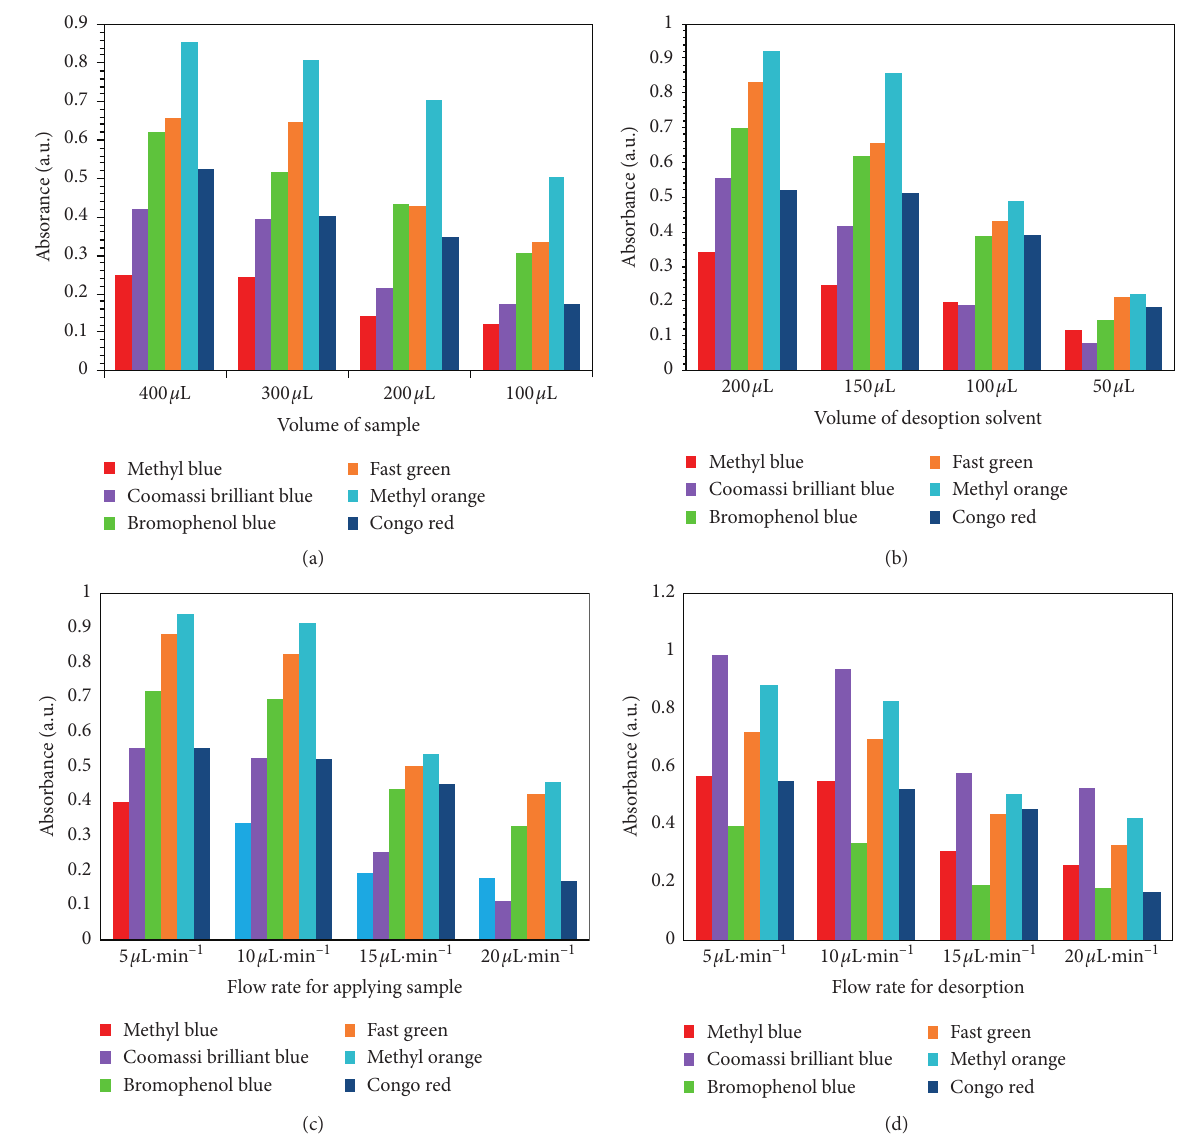
Figure 11: Effect of volume of dye sample solution on the extraction efficiency of dyes (a), volume of acetone (b), flow rate of applying sample (c), and flow rate for desorption solvent (d). Conditions: sample volume, 400 μ L; flow rate, 10 μ L · min − 1 ; dye concentration, 60mg · L − 1 ; desorption solvent (acetone) volume, 200 μ L; flow rate, 5 μ L · min − 1